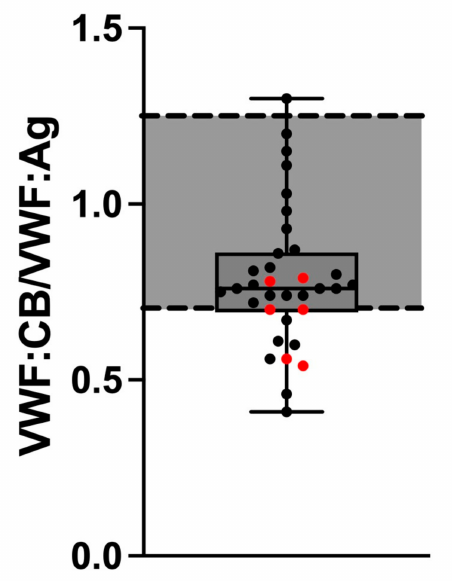
Figure 3. VWF:CB/VWF:Ag ratio in cholestatic ( red dots ) and non-cholestatic Fontan